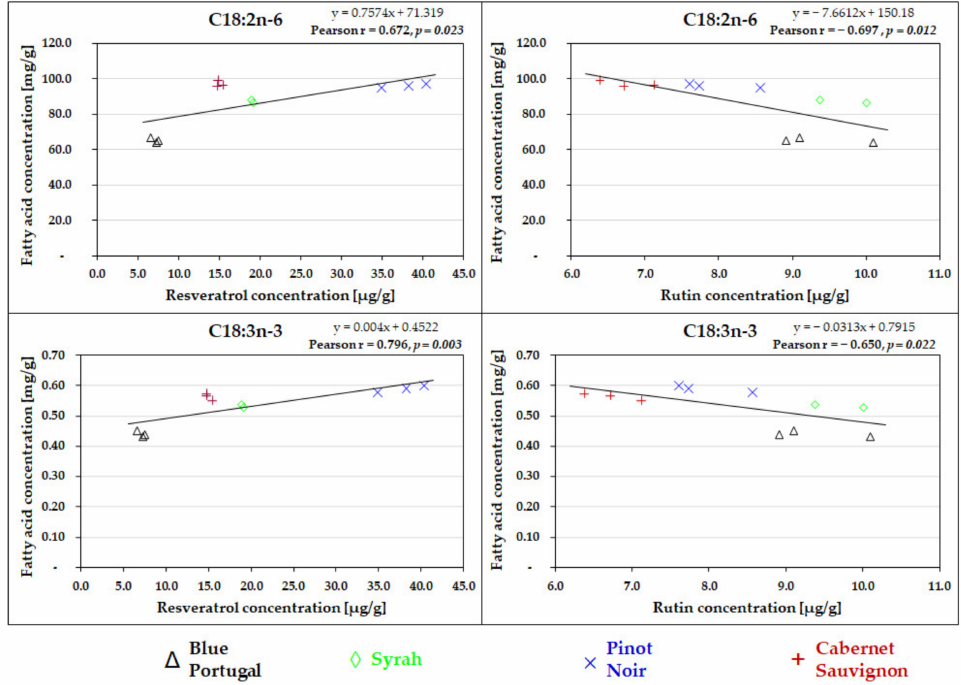
Figure 1. Correlations between the essential fatty acids (C18:3n-3 and C18:2n-6) and polyphenols (resveratrol and rutin) in grape seed pomace of four different grape